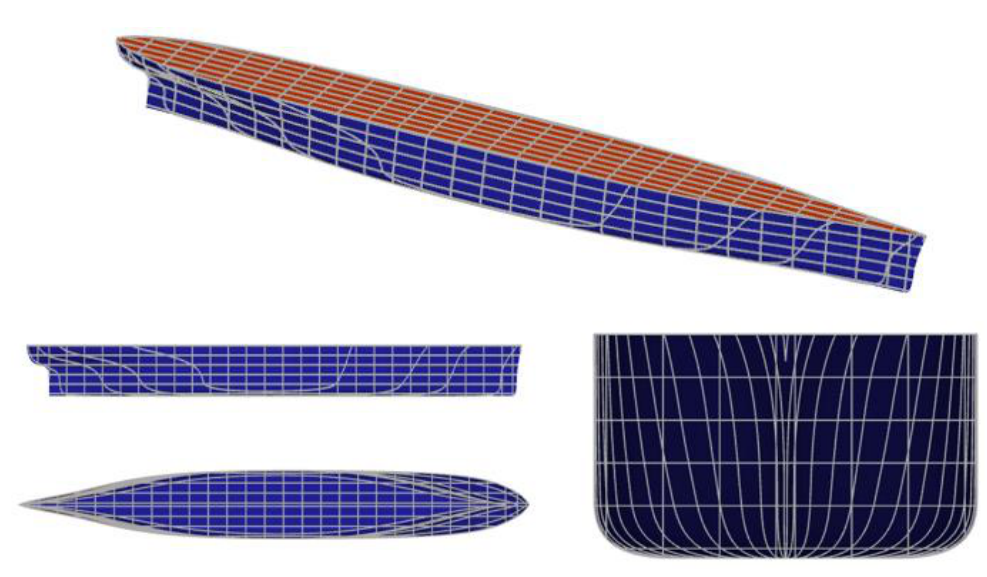
Figure 17. Series 60 parametric model view.